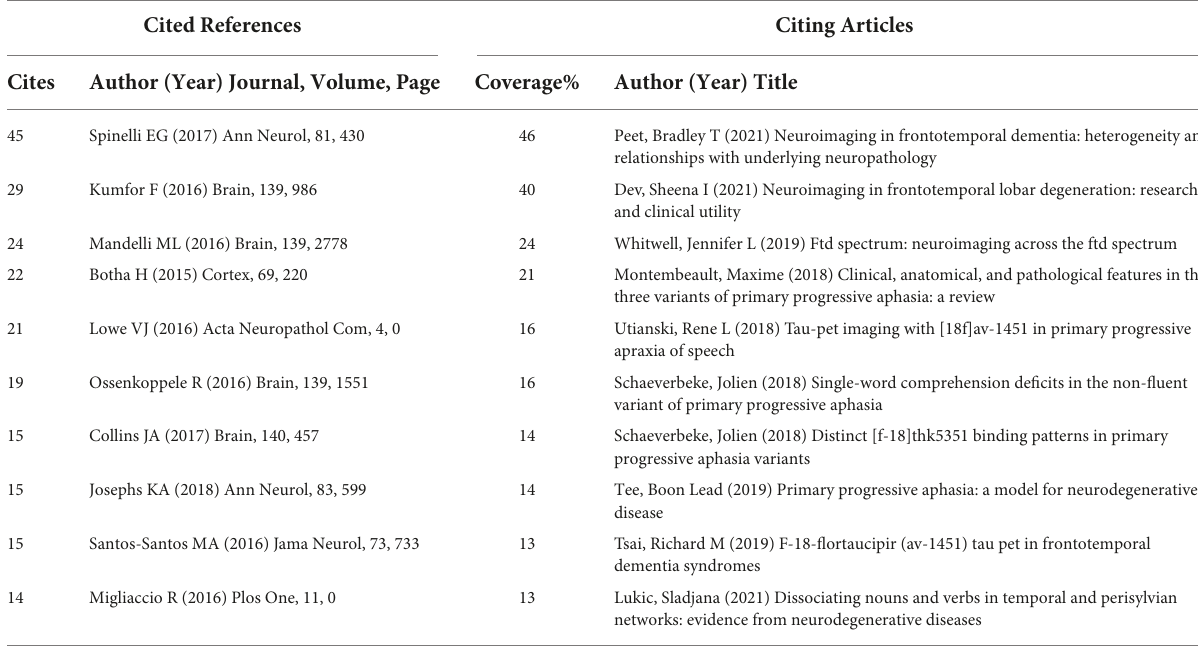
TABLE 6 Cited references and citing articles of Cluster #2 on progressive supranuclear palsy.